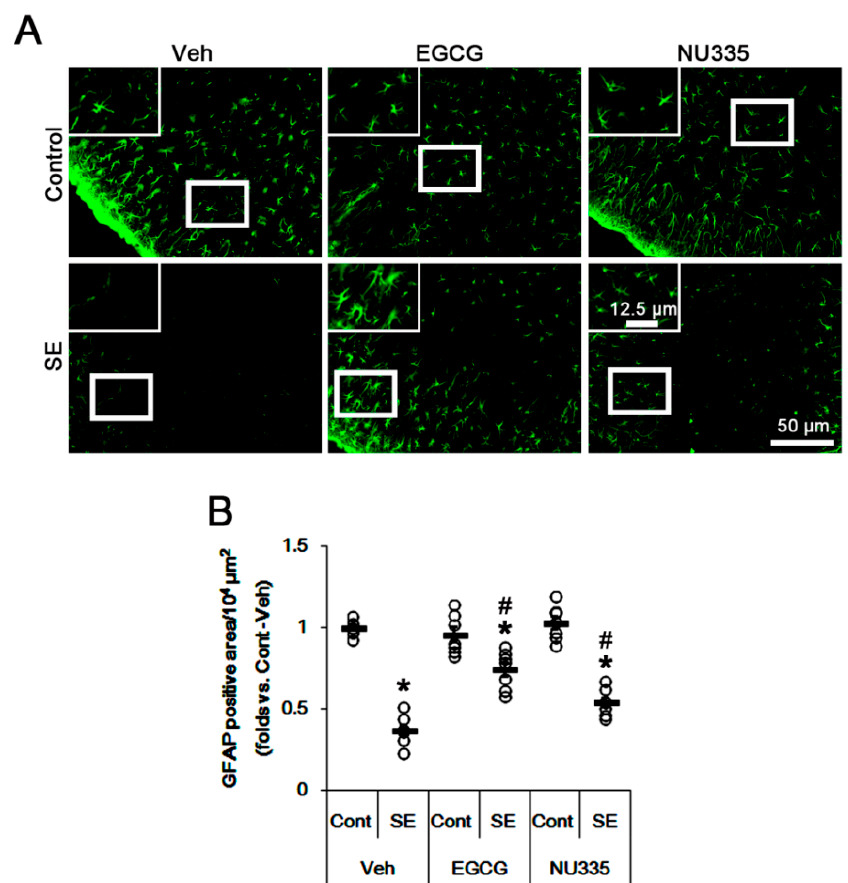
Figure 3. Astroglial responses to EGCG and NU335 in the PC under physiological and post-SE conditions. EGCG and NU335 do not lead to reactive astrogliosis or astroglial loss under physiological conditions. However, both EGCG and NU335 attenuate astroglial degeneration induced by SE. ( A ) Representative photos for glial fibrillary acidic protein (GFAP) in the PC under physiological (upper panels) and post-SE (lower panels) conditions. ( B ) Quantitative values of the e ff ect of EGCG and NU335 on the GFAP-deleted area in the PC following SE ( n = 7, respectively). Open circles indicate each individual value. Horizontal bars indicate mean value. Error bars indicate S.E.M. Significant di ff erences are * ,# p < 0.05 vs. control (non-SE) animals and vehicle-treated animals, respectively.